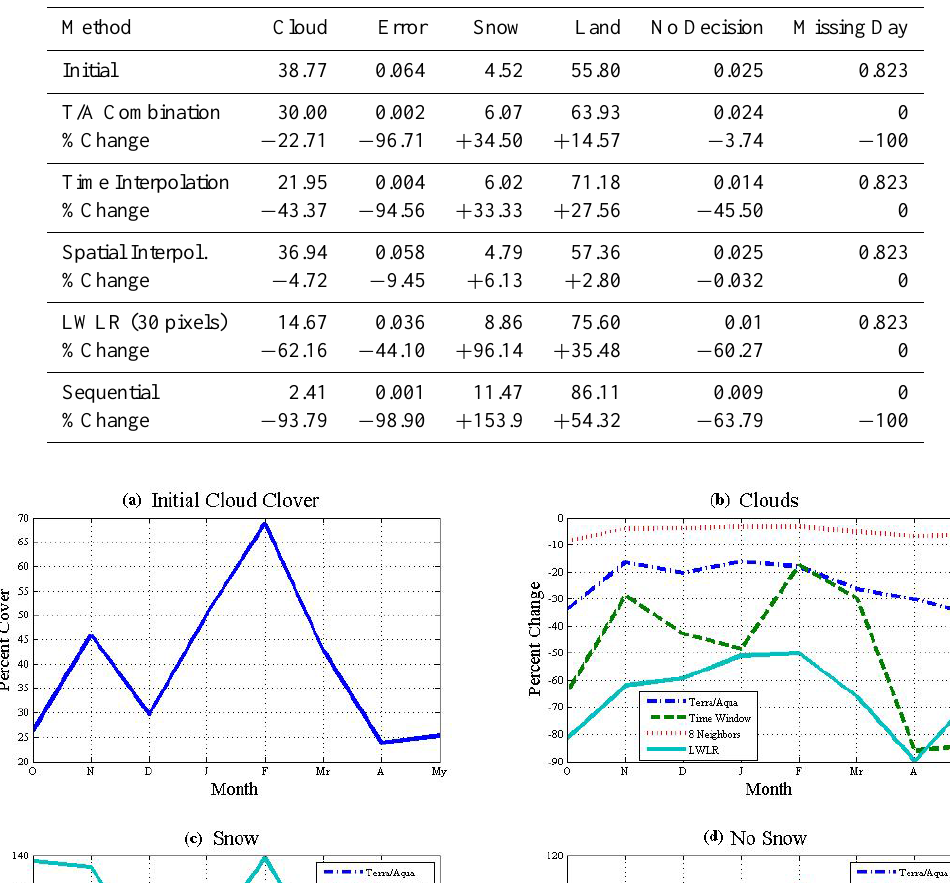
Table 1. “%Cover” change of the MOD10A1 images, achieved by each method for each category for the entire study period.